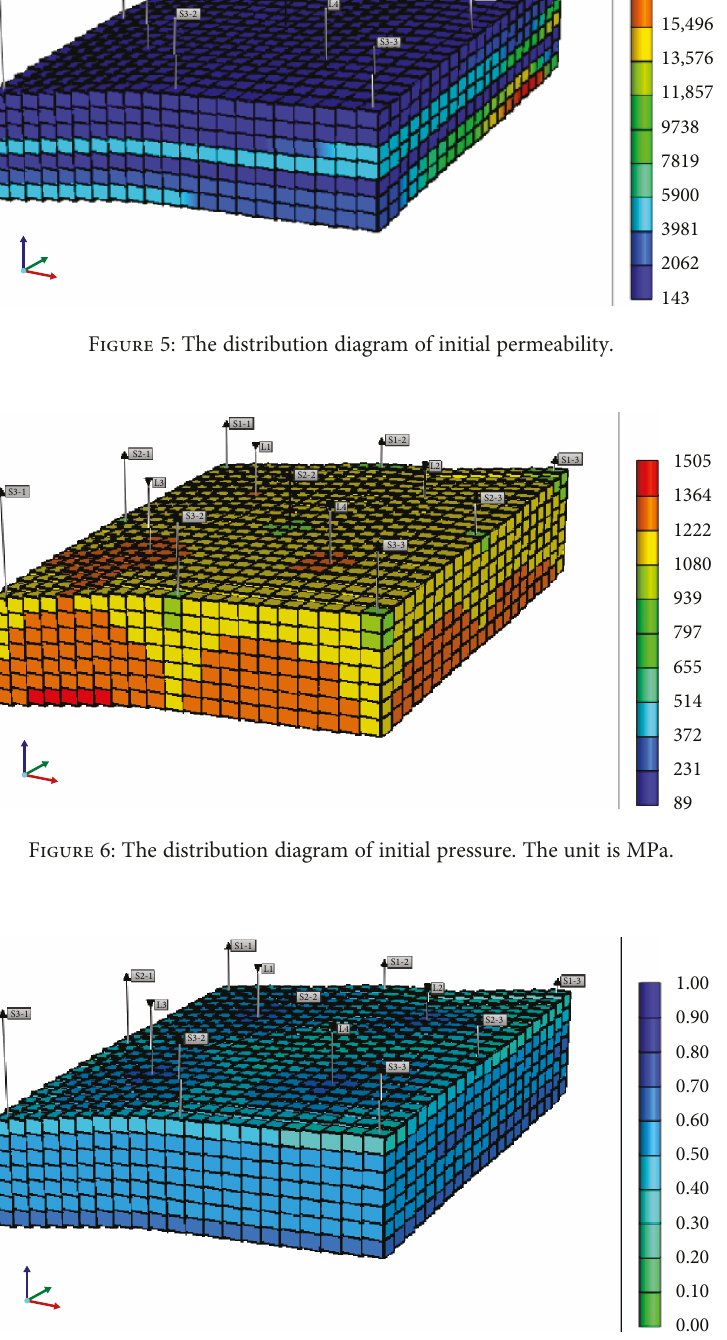
Figure 7: The distribution diagram of initial water saturation.